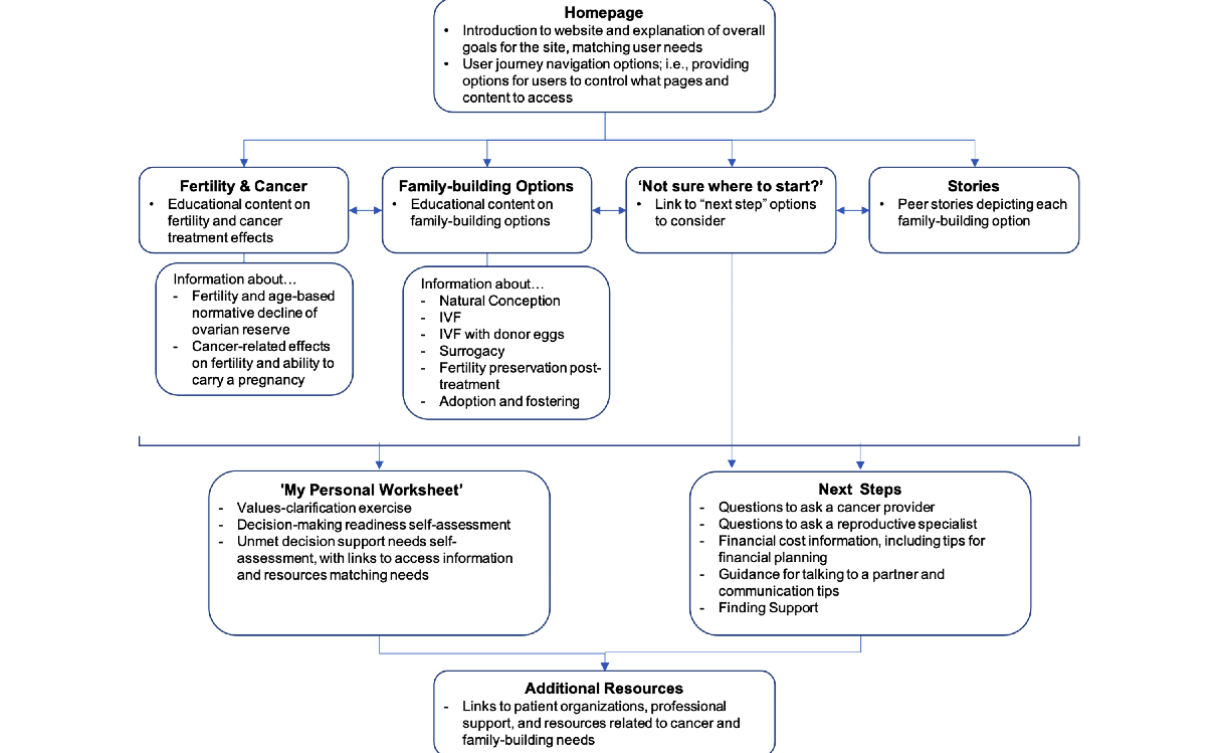
Figure 3. Depiction of the information architecture of the decision aid website. IPDAS: International Patient Decision Aid Society.